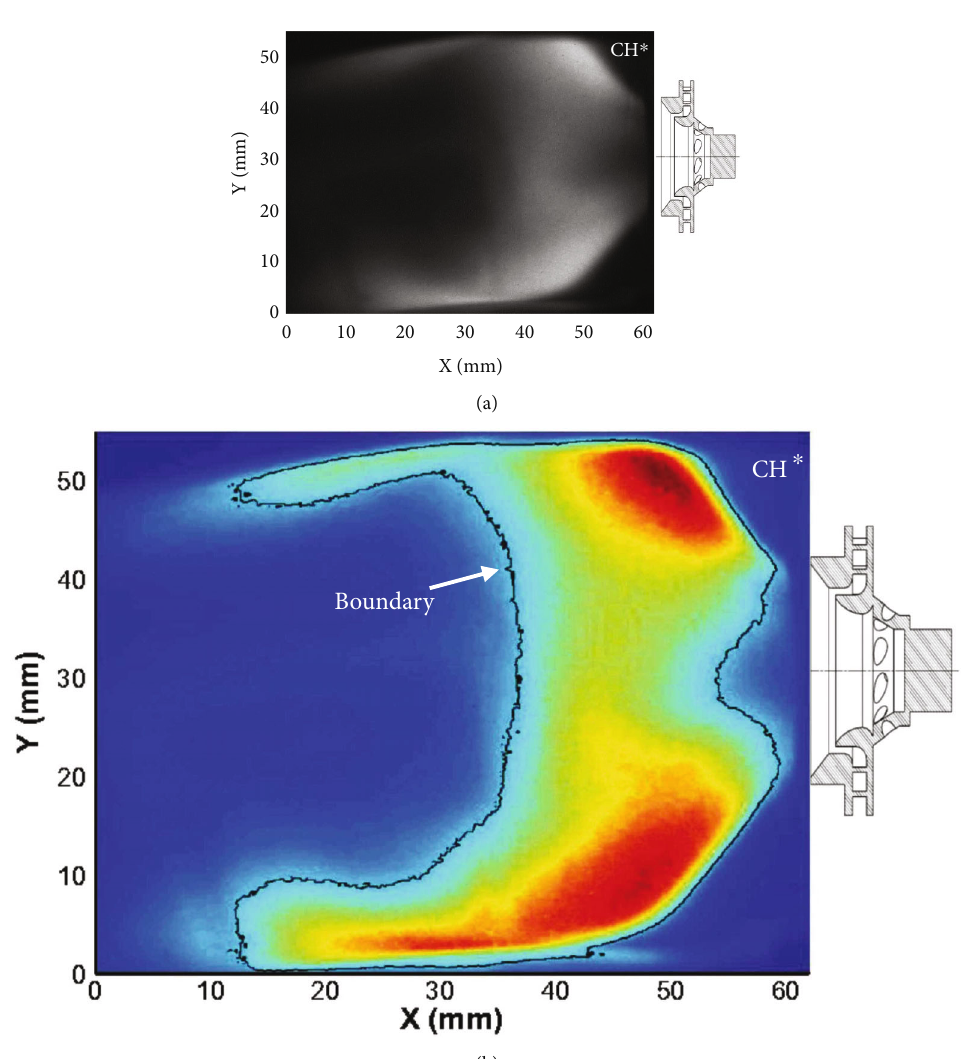
Figure 9: Image processing method: (a) original image and (b) post-processing